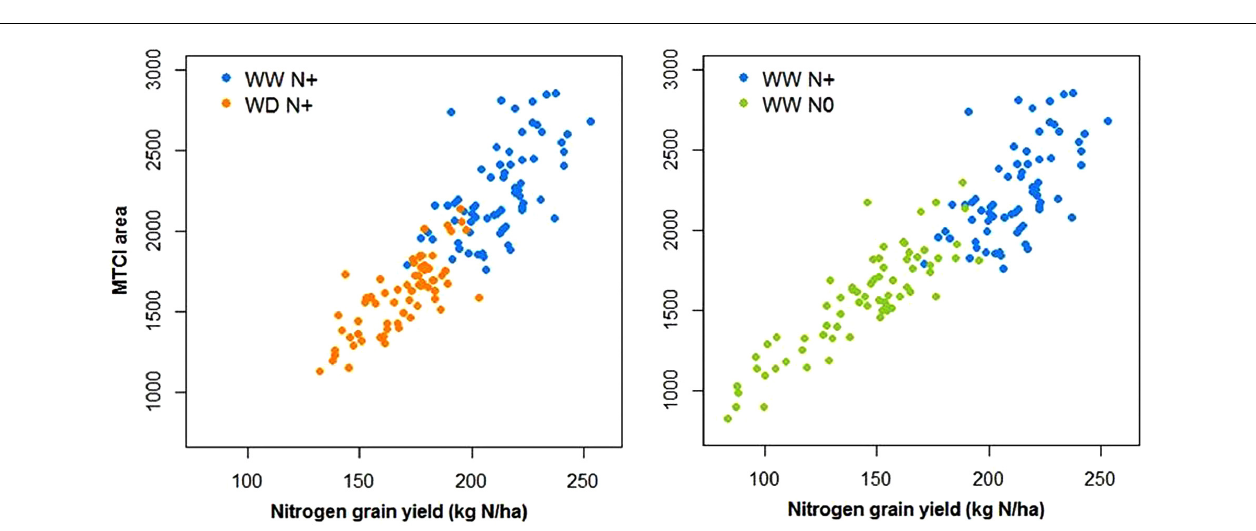
FIGURE 12 | Green fraction (%) during the growing season (A) with the mean of well-watered conditions with nitrogen input (WW N, in blue) against well-watered conditions without nitrogen input (WW N0, in green) and (B) with the mean of well-watered conditions with nitrogen input (WW N, in blue) against water deficient conditions with nitrogen input (WD N + , in orange, N = 44, ± SE) and curves of all varieties (in gray).